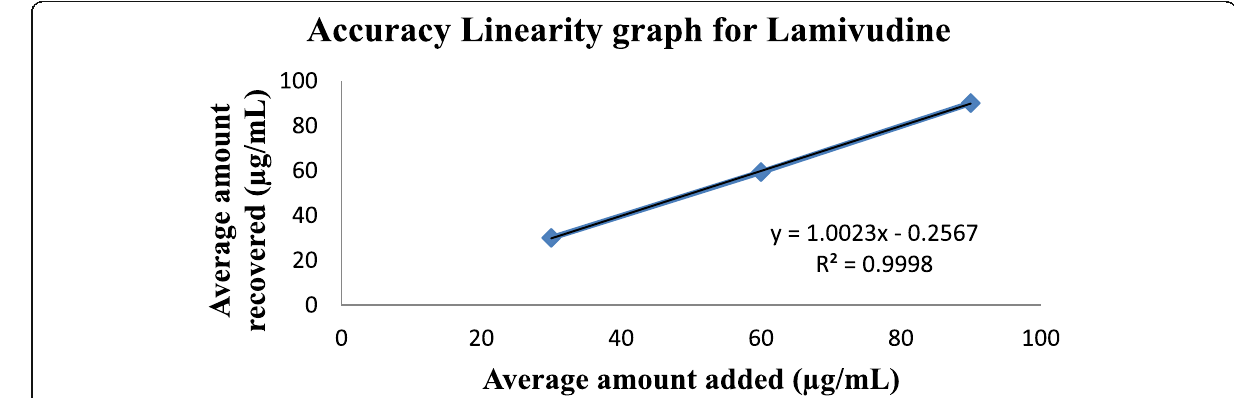
Fig. 8 Accuracy linearity of